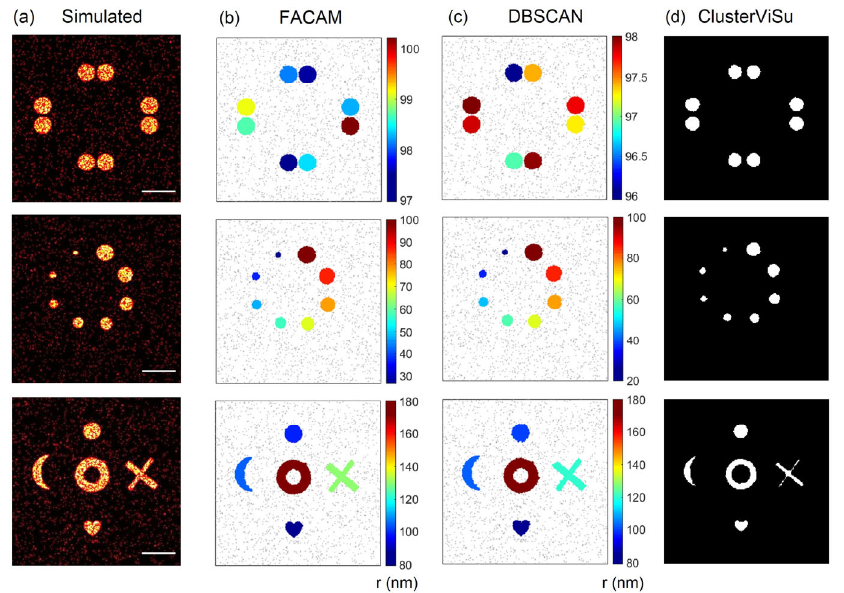
Figure 4. The clustering performance of FACAM, DBSCAN, and ClusterViSu on simulated datasets. ( a ) Reconstructed super-resolution images of the simulated datasets. Scale bar: 400 nm. ( b ) The clustering results from FACAM for the simulated datasets in ( a ). ( c ) The clustering results from DBSCAN for the simulated datasets in ( a ). ( d ) The clustering results from ClusterViSu for the simulated datasets in ( a ). Color bar = radius